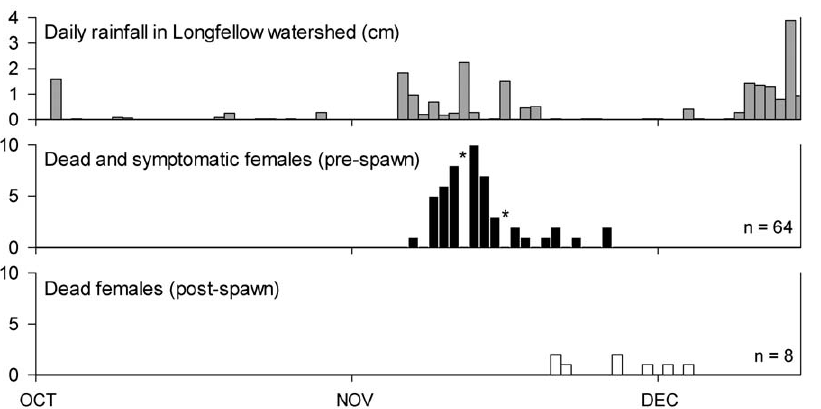
Figure 6. Pre-spawn mortality and survival to spawn in relation to rainfall. Shown are the results of daily stream surveys throughout the 2002 coho spawning season in Longfellow Creek in relation to daily rainfall. Asterisks (*) indicate days when stream flows were too high to survey the creek.